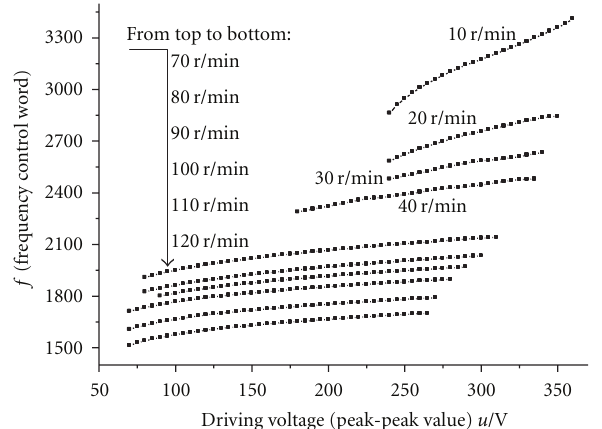
Figure 2: Tested data of speed